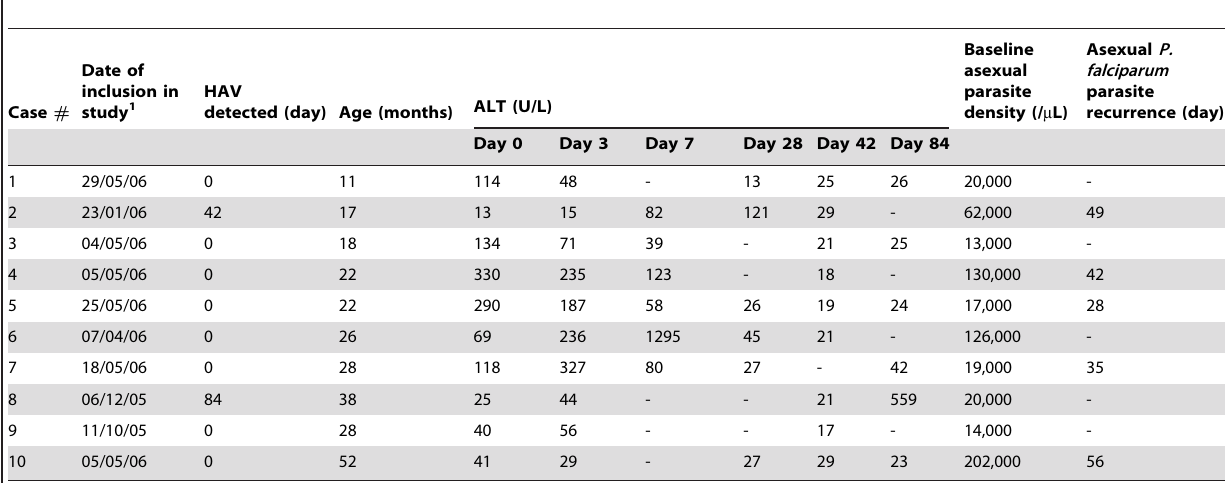
Table 2. Summary of key laboratory parameters of patients who presented with uncomplicated P. falciparum malaria and subsequently found to have anti-HAV IgM indicating acute HAV